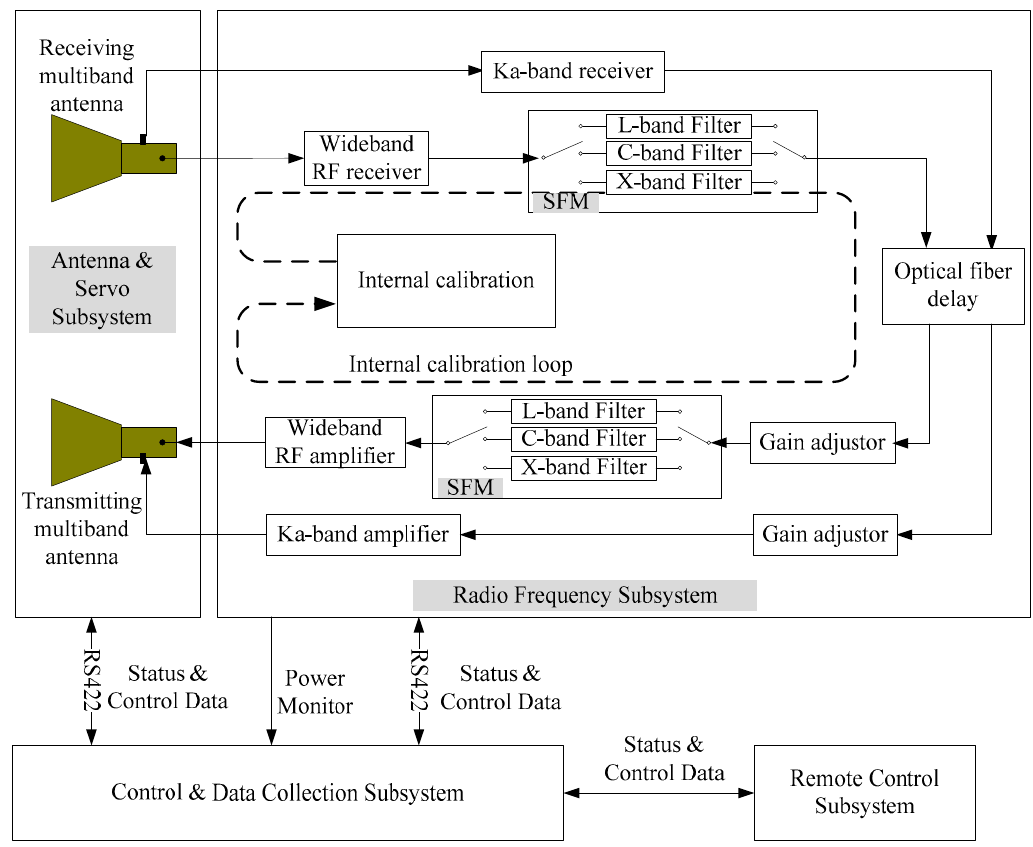
Figure 1. The block diagram of the active radar calibrator (ARC).